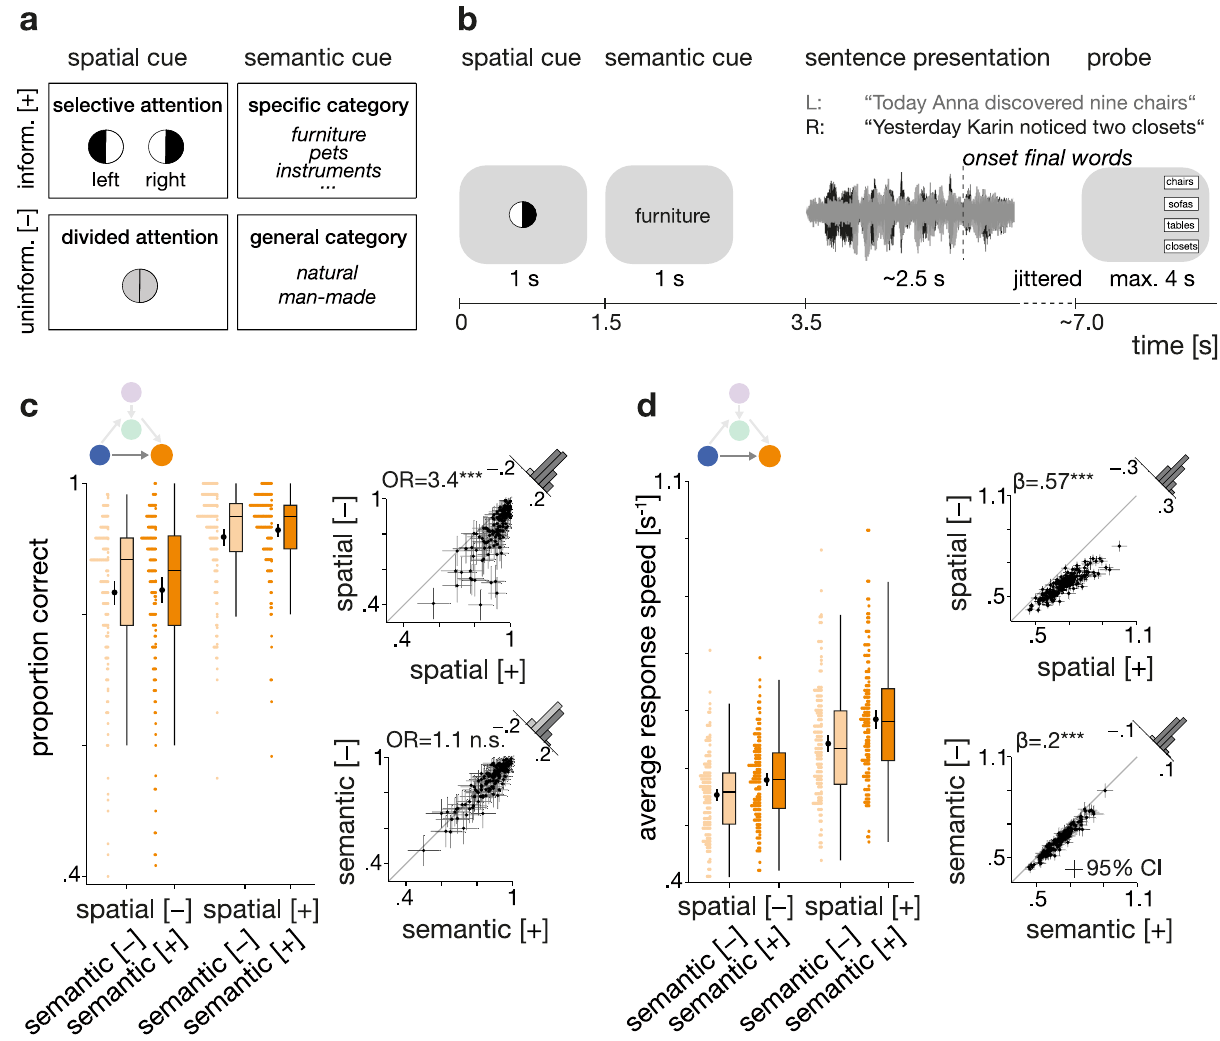
Fig. 2 Experimental design and behavioural bene fi t from informative cues. a Visualization of used 2 × 2 design 35 . Levels of spatial and semantic cues differed on a trial-by-trial basis. Note that the effects of the semantic cue were of secondary importance to the current analyses. Top row shows the informative [ + ] cue levels, bottom row the uninformative [ – ] cue levels. b Schematic representation of the trial structure. Successive display of the two visual cues precedes the dichotic presentation of two sentences spoken by the same female talker. After sentence presentation, participants had to select the fi nal word from four alternative words. c Left: accuracy per cue – cue combination. Coloured dots are individual ( N = 155 participants) trial averages, black dots and vertical lines show group means with bootstrapped 95% con fi dence intervals (CI). Right: Individual cue bene fi ts displayed separately for the two cues (top: spatial cue, bottom: semantic cue). Black dots indicate individual ( N = 155) mean accuracy with bootstrapped 95 % CI. Histograms show the distribution of the difference in accuracy for informative vs. uninformative levels. OR: odds ratio parameter estimate from generalized linear mixed- effects models; two-sided Wald test (FDR-corrected); spatial cue: P = 1.36 × 10 – 24 ; semantic cue: P = 0.68. d Left: Response speed per cue – cue combination. Coloured dots show individual ( N = 155 participants) mean speed, black dots and vertical lines show group means with bootstrapped 95% CI. Right: Individual cue bene fi ts displayed separately for the two cues (top: spatial cue, bottom: semantic cue). Black dots indicate individual ( N = 155) mean speed with bootstrapped 95% CI. Box plots in ( c ) and ( d ) show median centre line, 25th to 75th percentile hinges, whiskers indicate minimum and maximum within 1.5 × interquartile range. β : slope parameter estimate from general linear mixed-effects models; two-sided Wald test (FDR-corrected); spatial cue: P = 4.49 × 10 – 48 ; semantic cue: P = 2.49 × 10 – 9 . Source data are provided as a Source Data fi